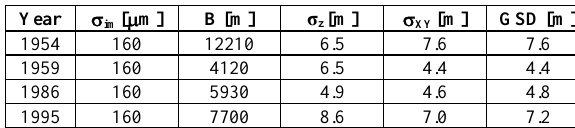
Table 5. Expected theoretical accuracy for 3D points